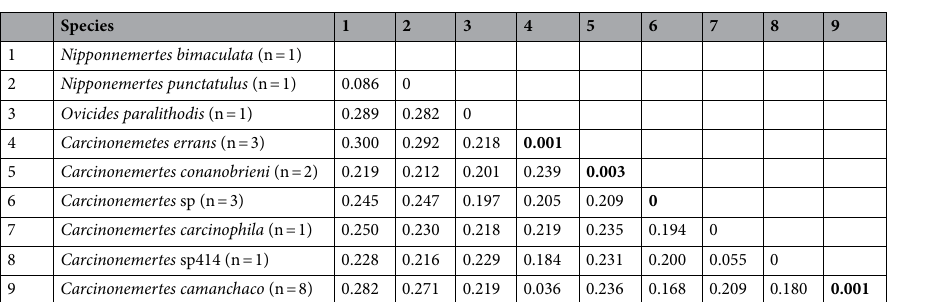
Table 2. Genetic distance between sequences of Carcinonemertes spp. available in GenBank and sequences of C. camanchaco sp. nov. provided in this study. In bold, intra-specific distances (sequences > 2).